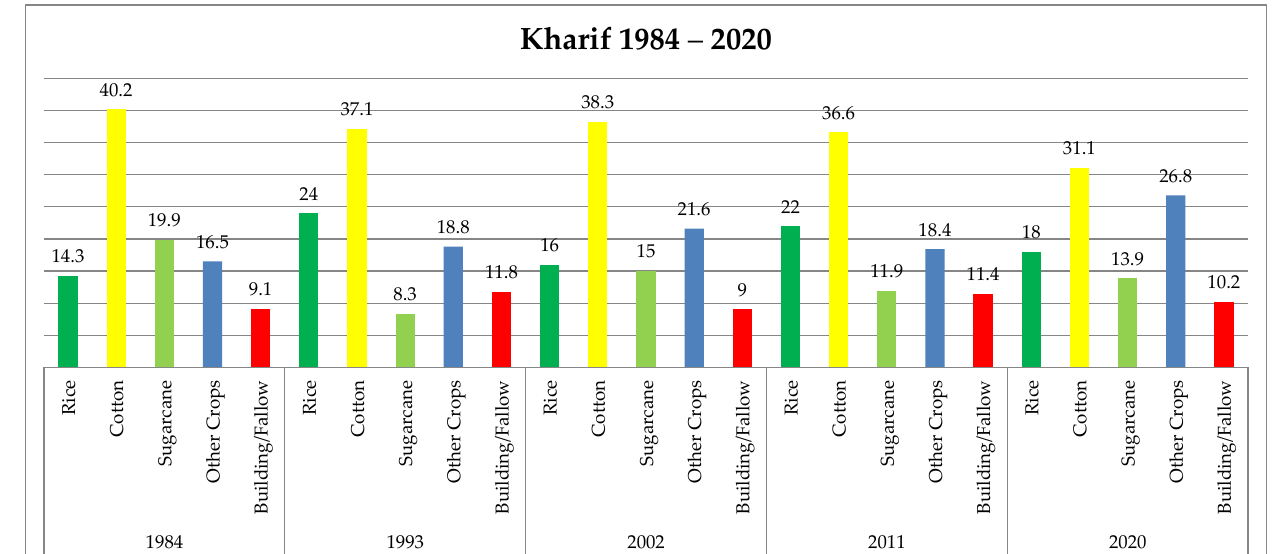
Figure 7. Cultivated are major crops during Kharif seasons in District Vehari.